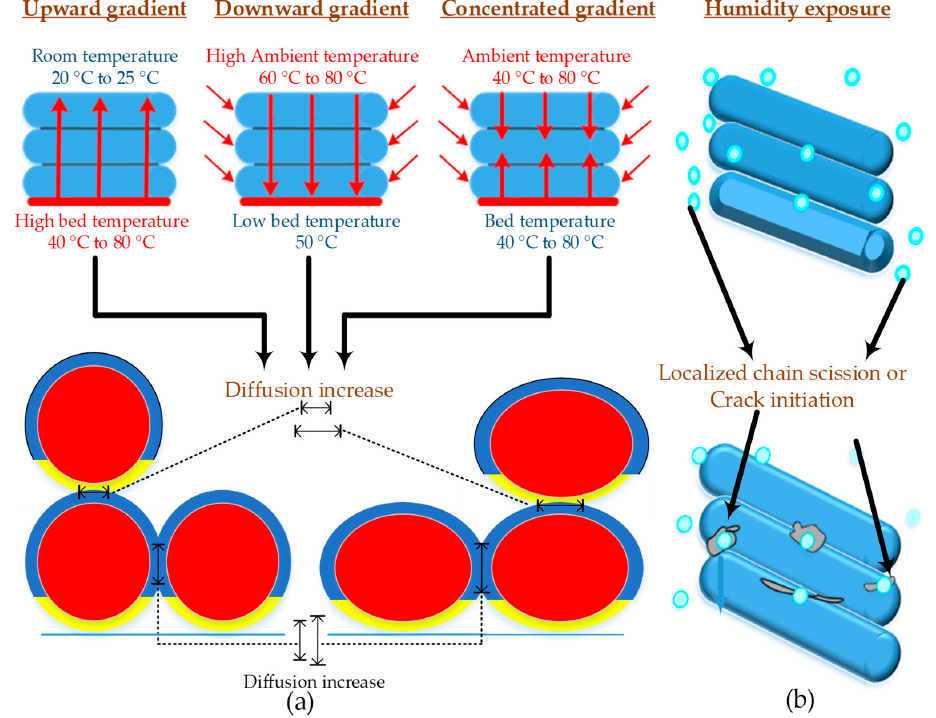
Figure 5. Illustration of in-process and post-process processing on printed structure of PLA: ( a ) in-process thermal treatment at different types of heat gradients; and ( b ) effect of moisture on localized areas.